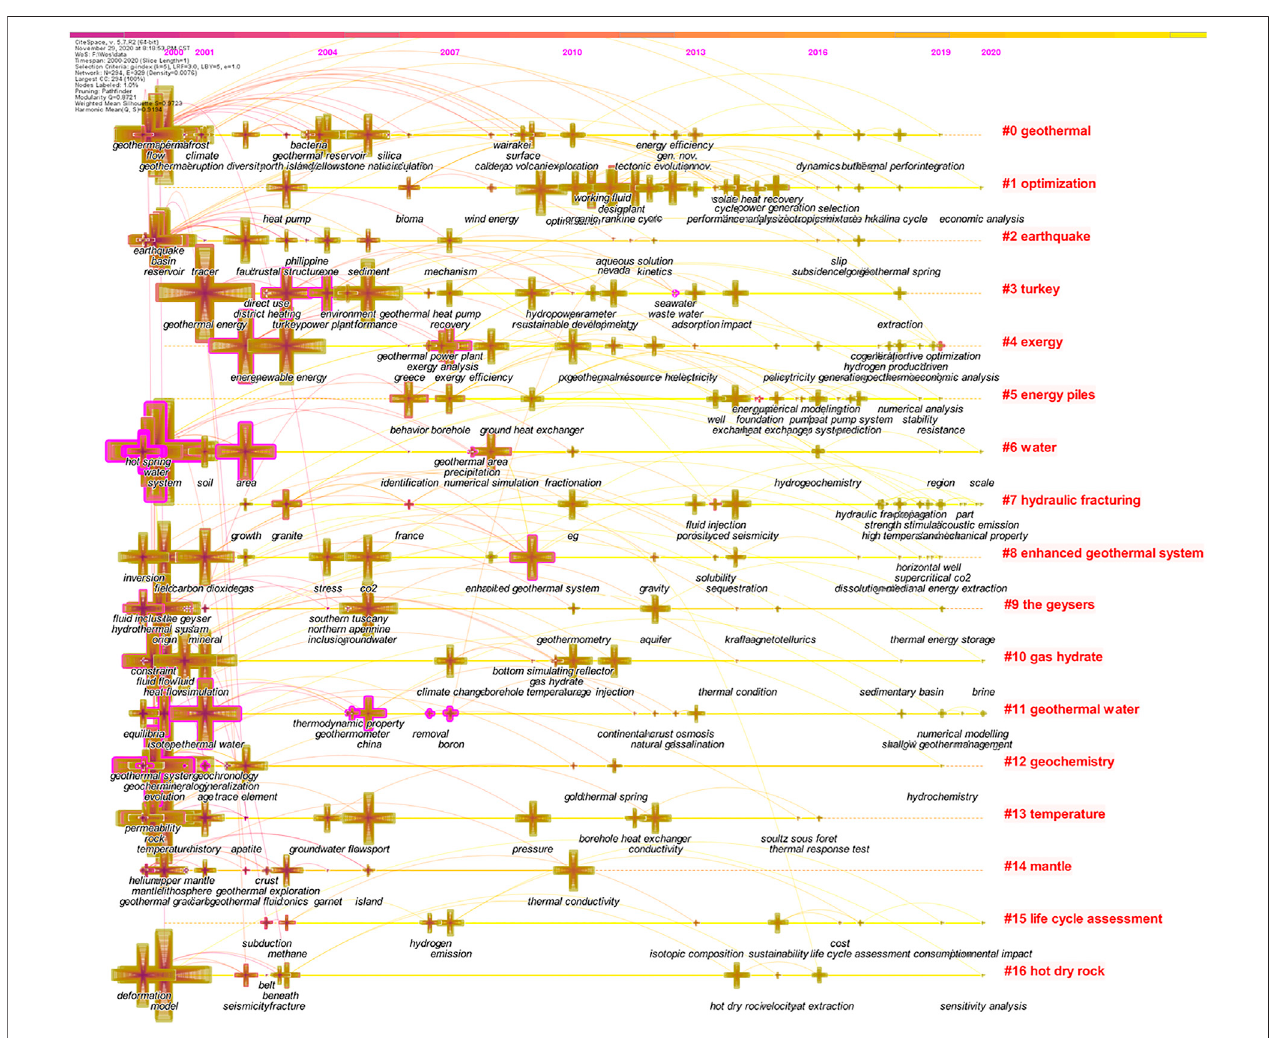
FIGURE 12 | Timeline view of